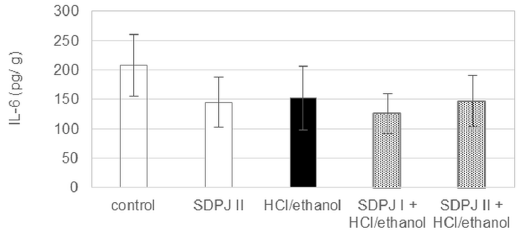
Figure 7. Effect of spray-dried potato juice (SDPJ) on the level of gastric IL-6 in rats treated with the mixture of HCl/ethanol. SDPJ I: SDPJ 200 mg/kg. SDPJ II: SDPJ 500 mg/kg. HCl/ethanol: the mixture of 0.3 M HCl and 60% ethanol (1:1). Values represent the means ±SD ( n = 8).